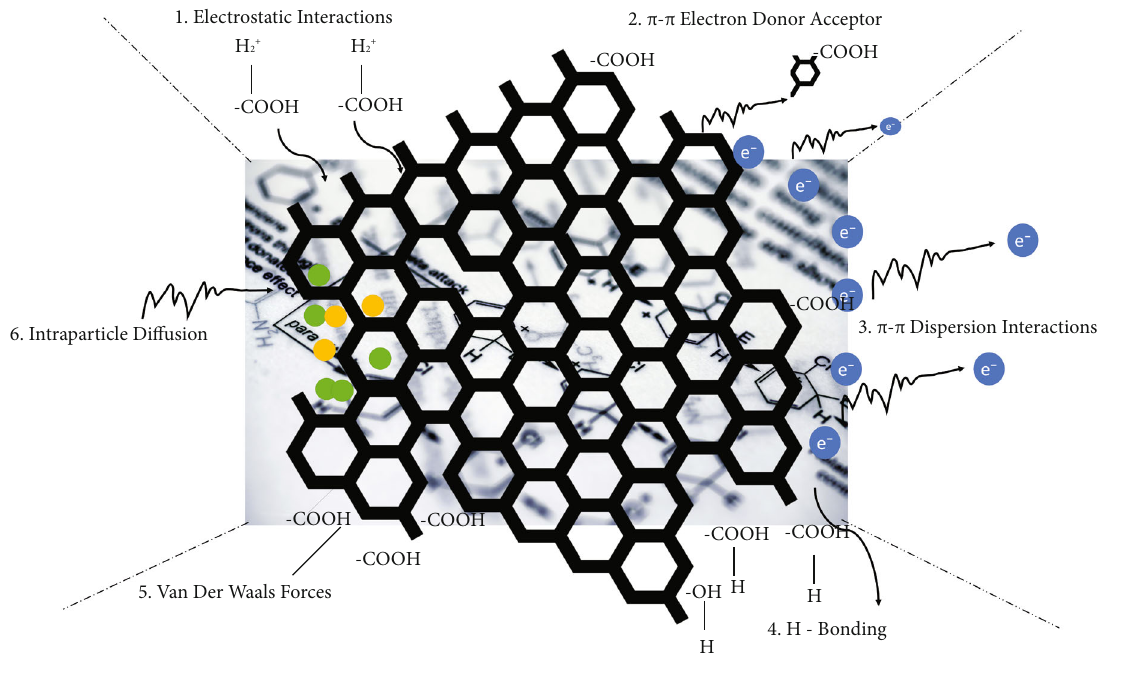
Figure 3: General adsorption mechanism of organic